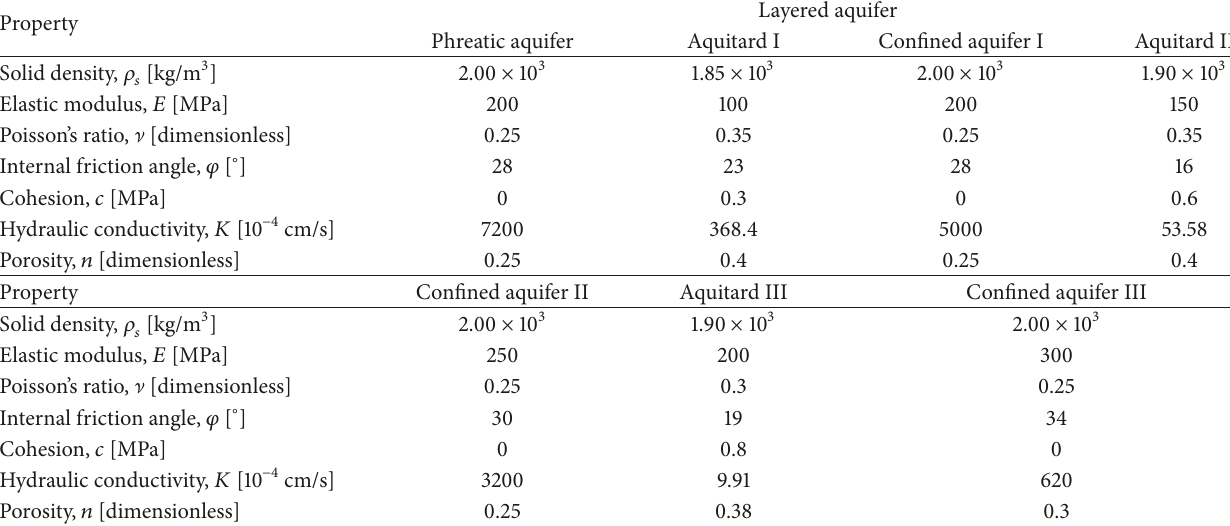
Table 1: Material properties of the multilayer aquifer system used in the numerical